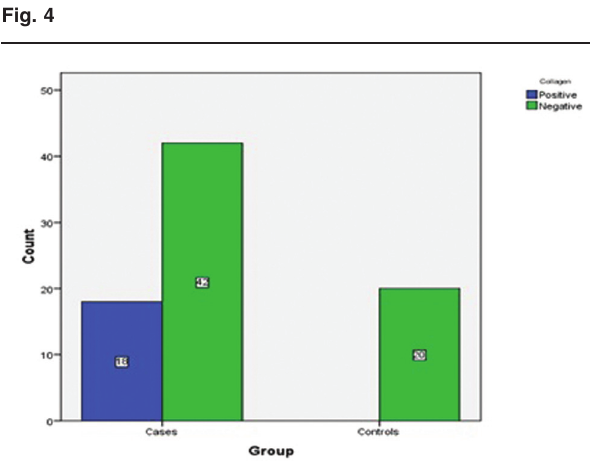
Comparison between cases and controls regarding collagen markers.